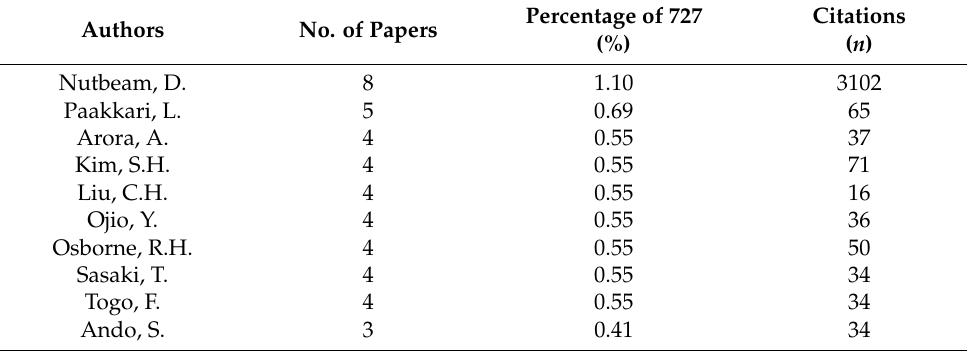
Table 3. The main authors who published the most on Health Literacy and Health Education in Web of Science Core Collection (data obtained from the Web of Science and